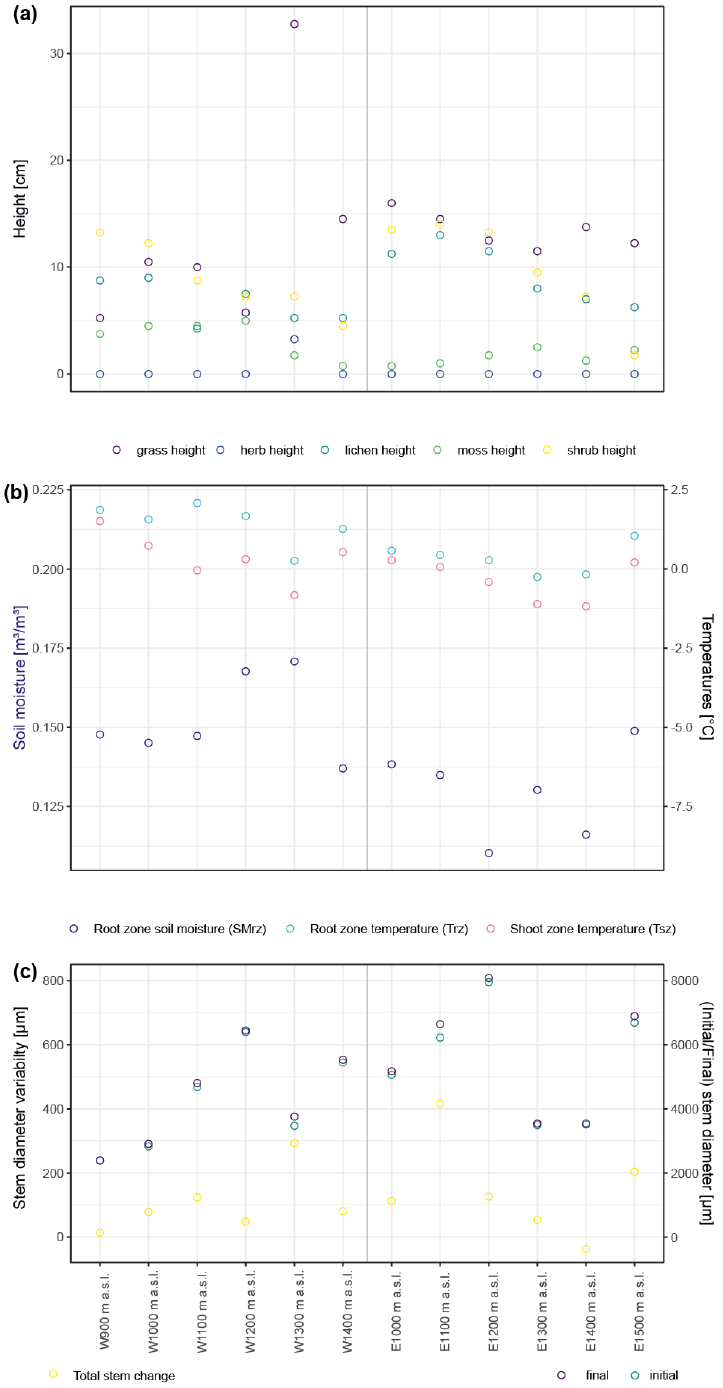
Figure A2. Summary of canopy height at the 12 studied sites by major vegetation type (a) . Trees are not included because there were no trees present. Panel (b) shows micro-environmental conditions averaged over the studied period, as well as minima and maxima for temperatures measured within the shoot and root zones and for soil moisture in the root zone. Panel (c) summarizes the total stem diameter change as well as stem diameter at the start and end of the studied period